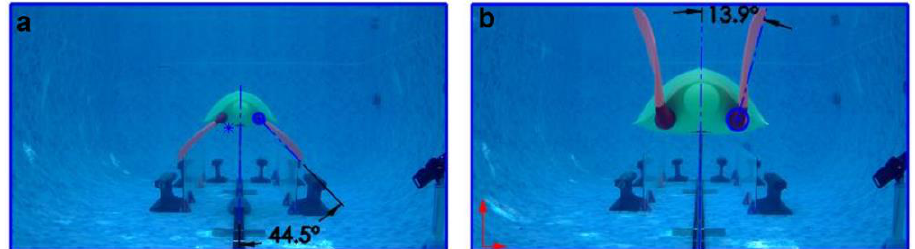
Figure 5. Upstroke data collection showing wings of 35° twist during a 0.6 m/s pull test. ( a ) Beginning of upstroke as wings leave the 135° constrainer. ( b ) Top of the upstroke measured anticlockwise from the vertical axis.